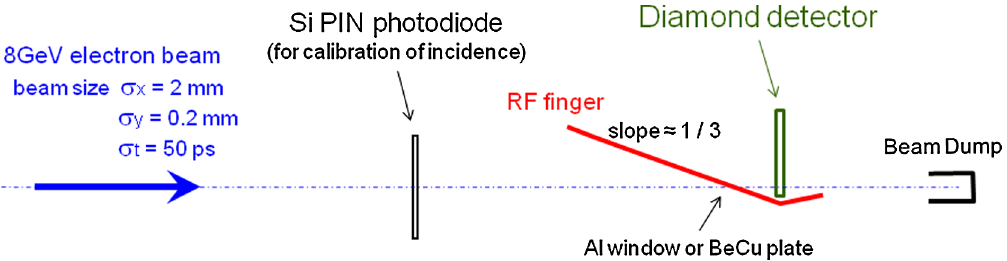
FIG. 6. Experimental setup to evaluate the effect of